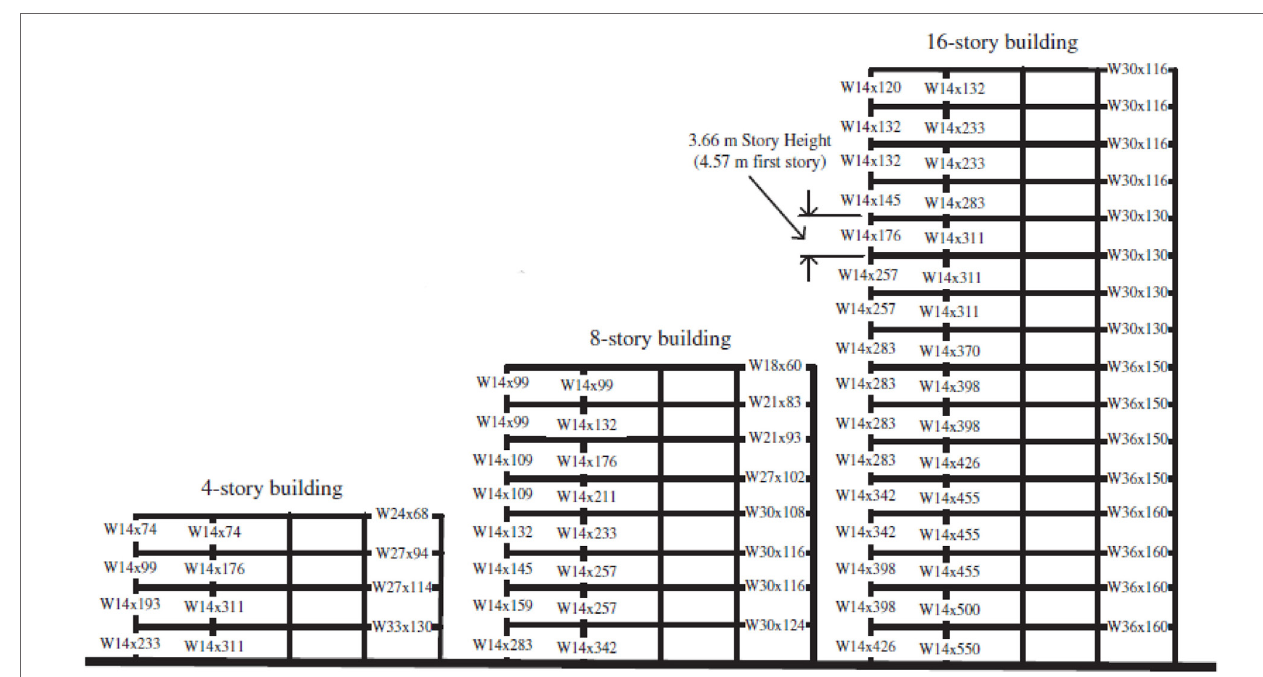
Figure 5 | Elevation of 4-, 8-, and 16-storey frames to be used in pushover analyses (Ghassemieh and Kiani, 2012).